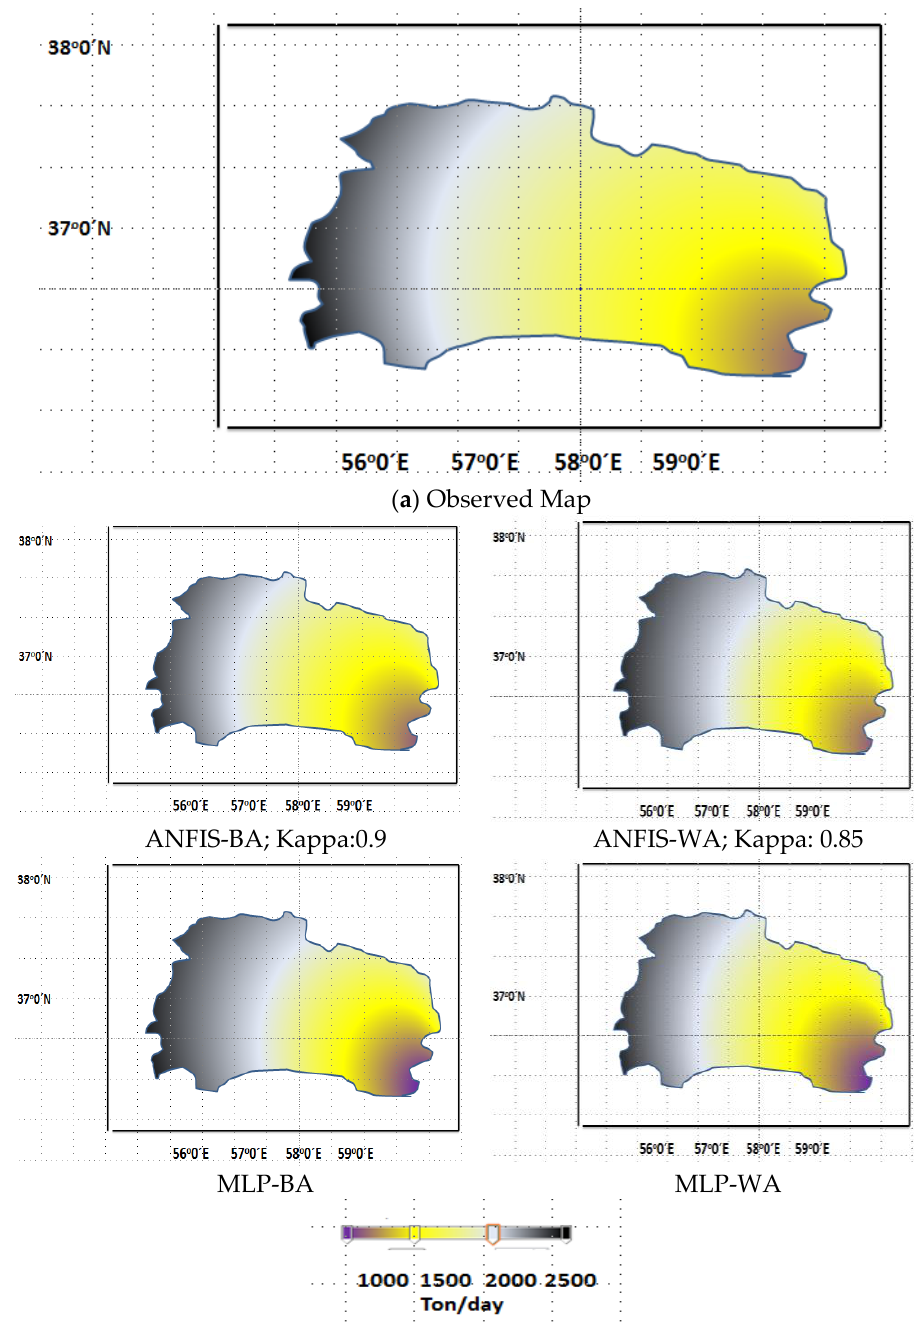
Figure 16. Monthly average suspended sediment load.